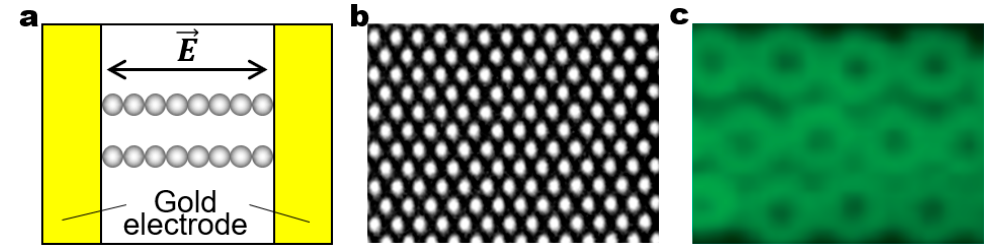
Figure 3. Field-driven dynamic structuring in a planar electric field. ( a ) Schematic of the experimental setup for a planar electric field. An AC electric field is applied between gold electrodes. Upon application of the field, dispersed particles self-assemble into linear chains aligned parallel in the field direction. The linear chains can be further assembled into 2D colloidal crystal structures from ( b ) 1.4 µ m spherical (Reproduced with permission [42]; Copyright 2004, American Chemical Society), ( c ) 2.5 µ m hexagonal (Reproduced with permission [43]; Copyright 2008, American Chemical Society).